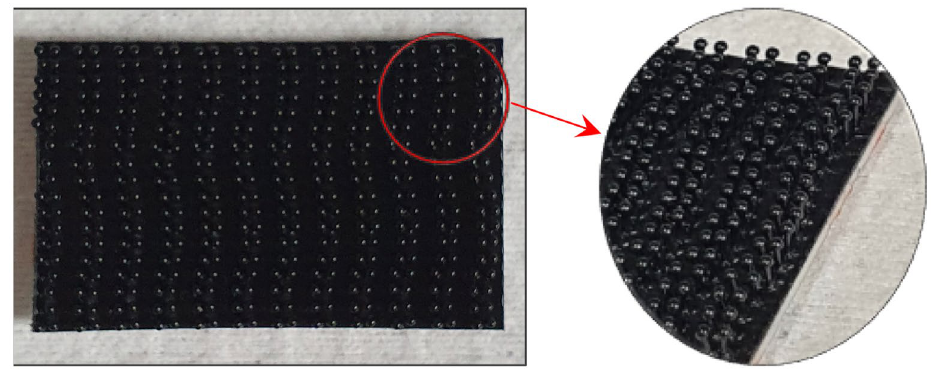
Figure 1. Dual-Lock fastener consisting of polyolefin backing covered with small mushroom-shaped